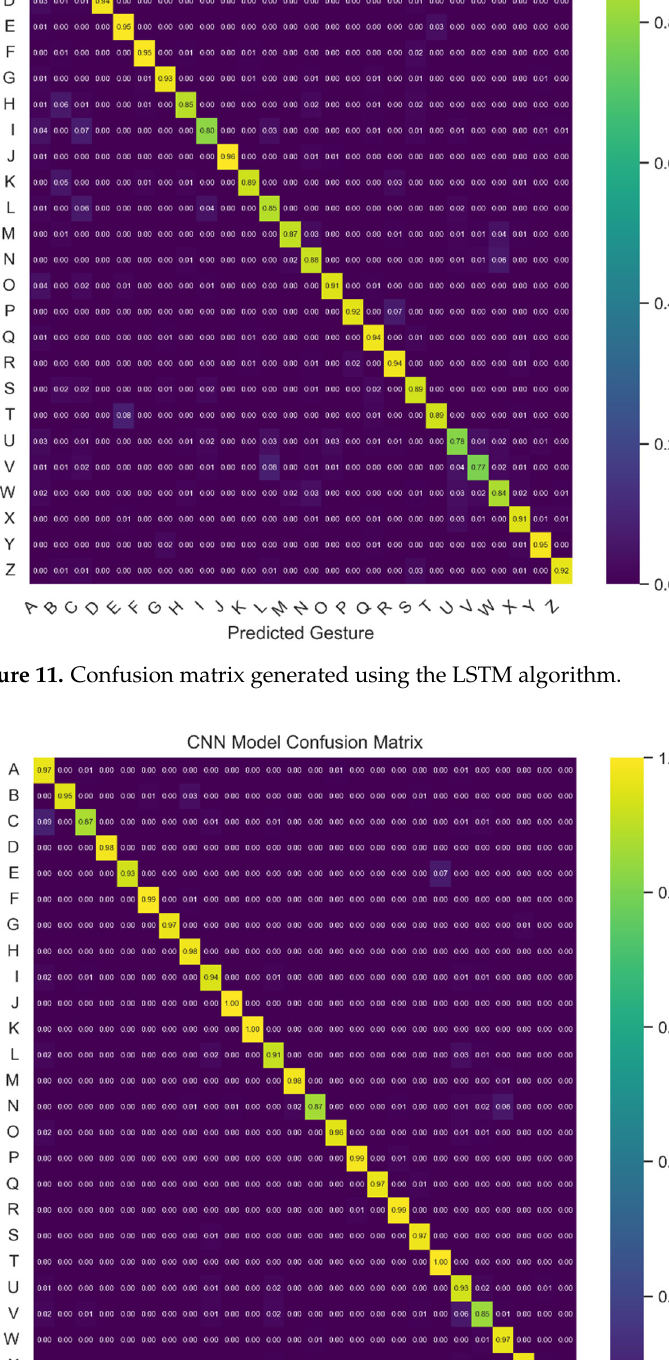
Figure 10. Confusion matrix generated using the BILSTM algorithm.